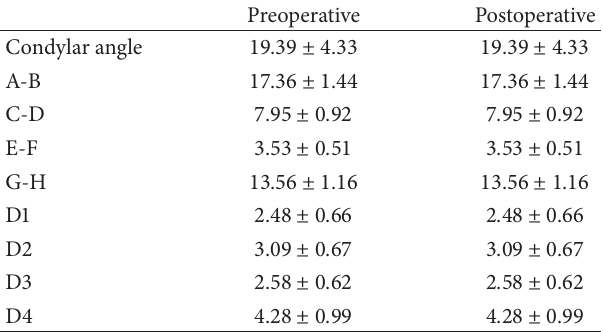
Table 4: Changes in CBCT